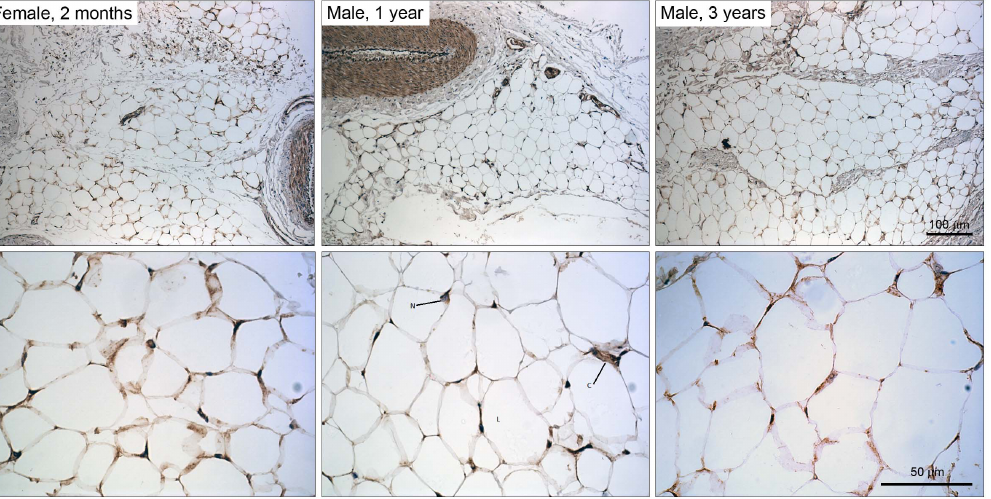
Figure 4. Representative immunohistochemical staining confirming expression of the leptin protein in three independent elephant adipose tissue specimens. Dark brown staining indicates leptin. Leptin was expressed exclusively in the cytoplasm of adipocytes. The top panel shows micrographs of leptin staining at 10 6 magnification and the lower panel shows micrographs at 40 6 magnification; N=nucleus, L=lipid droplet, C=cytoplasm.